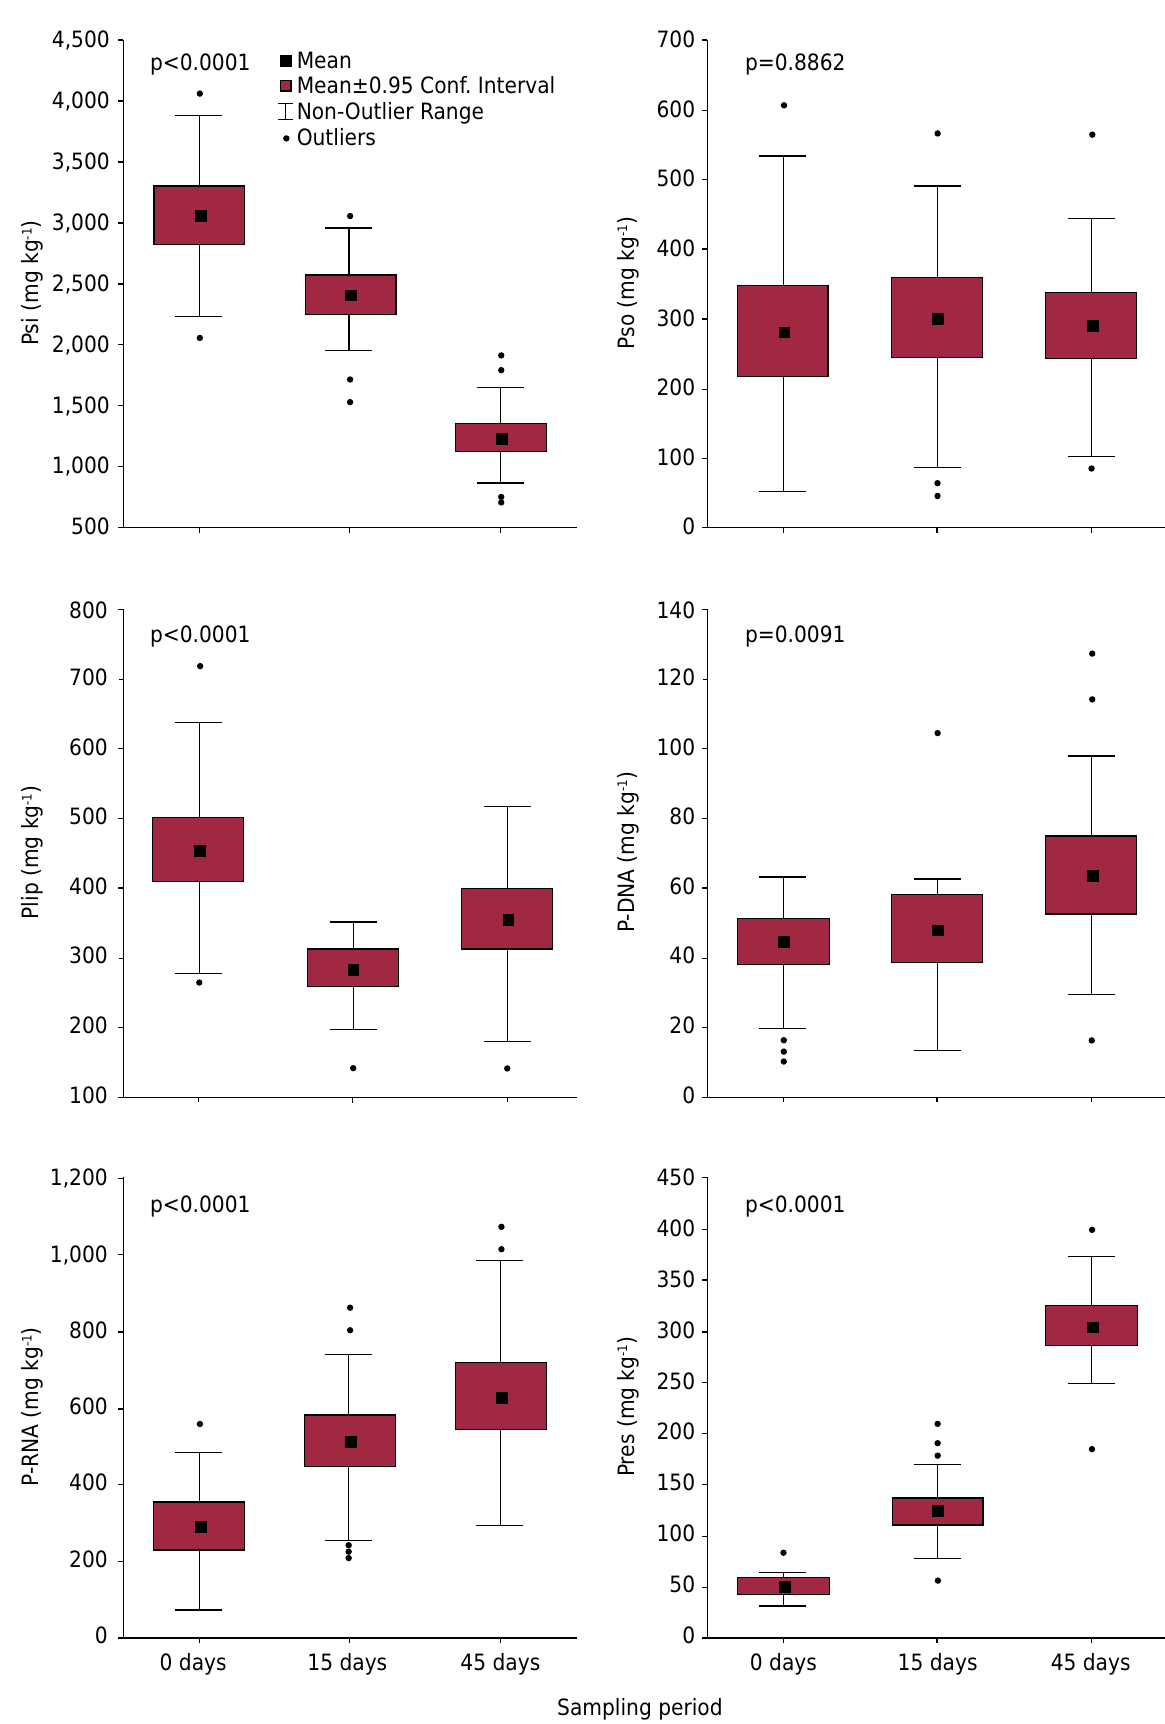
Figure 3. Content of P forms in the plant tissue of all treatments evaluated in terms of sampling time (time 0 and at 15 and 45 days after the deposition of decomposition bags). Psi: soluble inorganic P, Pso: soluble organic P, Plip: lipidic P, P-DNA: P associated with DNA; P-RNA: P associated with RNA; and Pres: residual P